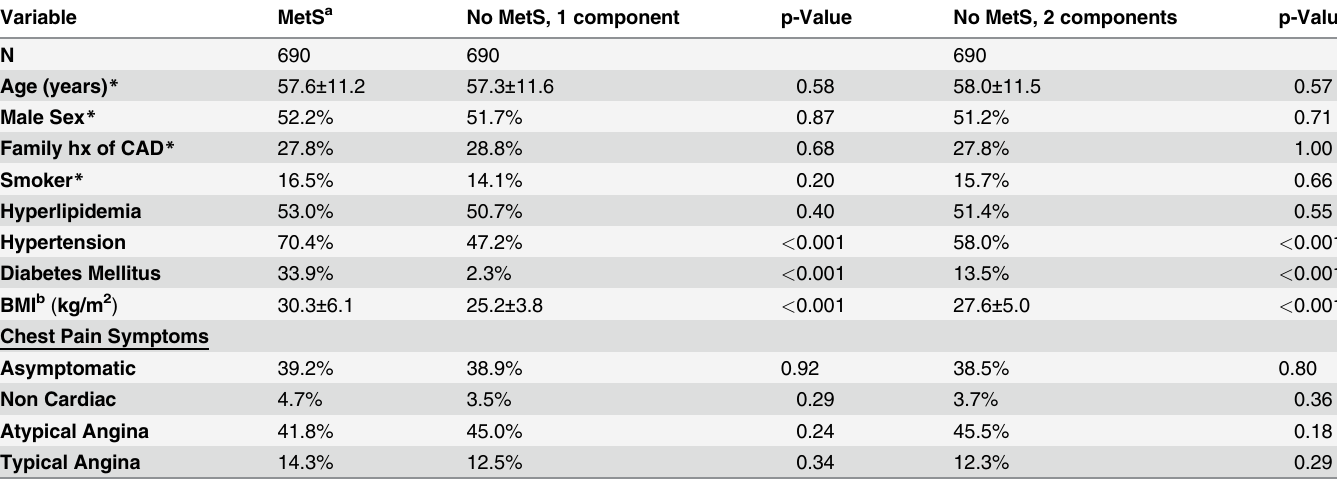
Table 1. Baseline characteristics of matched individuals with MetS versus those with individual components of MetS.